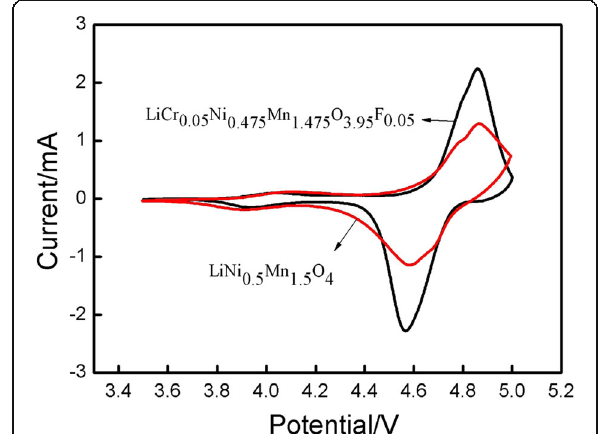
Fig. 6 Cycling performance of the LiNi 0.5 Mn 1.5 O 4 and LiCr x Ni 0.5